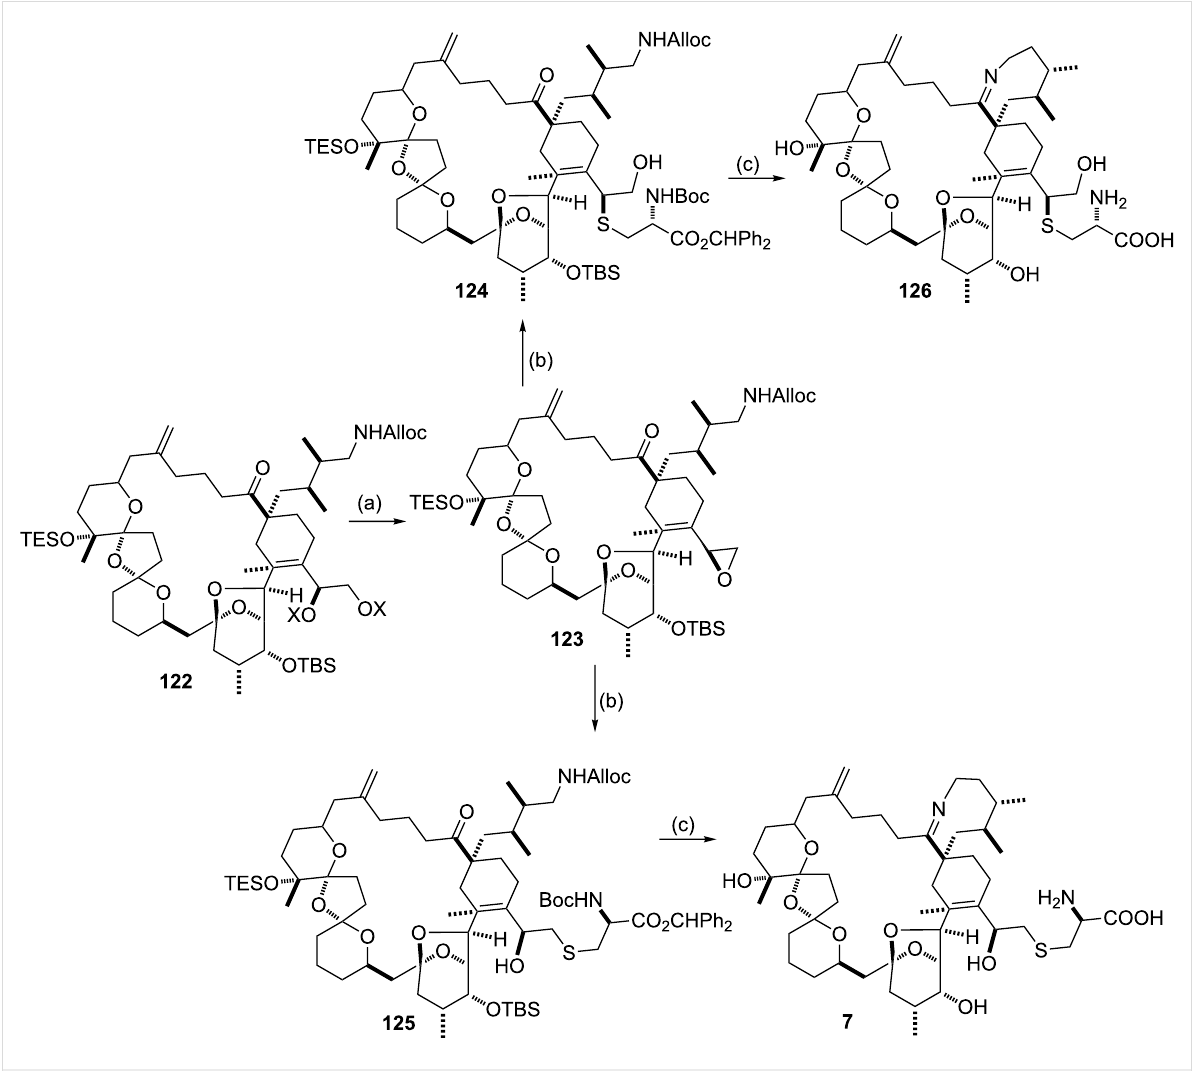
Scheme 43: Synthesis of pteriatoxins with epoxide thiolysis to attain β -hydroxy sulfides. Reagents: (a) (1) K 2 CO 3 ; (2) HF ∙ Py, Py, 74% over 2 steps; (2) TsCl; (3) K 2 CO 3, 78% over 2 steps; (b) N -Boc-L-Cys(SH)-OCHPh 2 , 85%; (c) (1) [Pd(PPh 3 ) 4 ], AcOH, 72%; (2) 1,3,5-(iPr) 3 C 6 H 2 CO 2 H/Et 3 N salt 80 °C, xylene; (3) TFA, CH 2 Cl 2 , followed by HPLC separation of 7 and 126 .